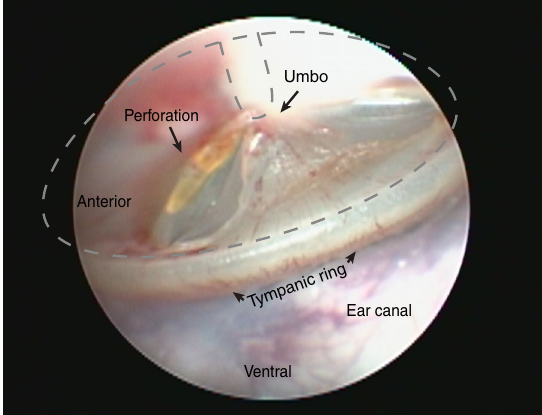
Figure 2. A large eardrum rupture seen after a single 175 dB blast. After each blast, we examined the ear canal and eardrum with an otoscope. Eardrum rupture was never seen after 160 dB or 165 dB blasts, but was sometimes seen after a single 175 dB blast (4/20 ears), and always seen after 5–10 consecutive 175 dB blasts (4/4). Ruptures were usually small tears in the inferior pars tensa, and a small amount of bleeding was often